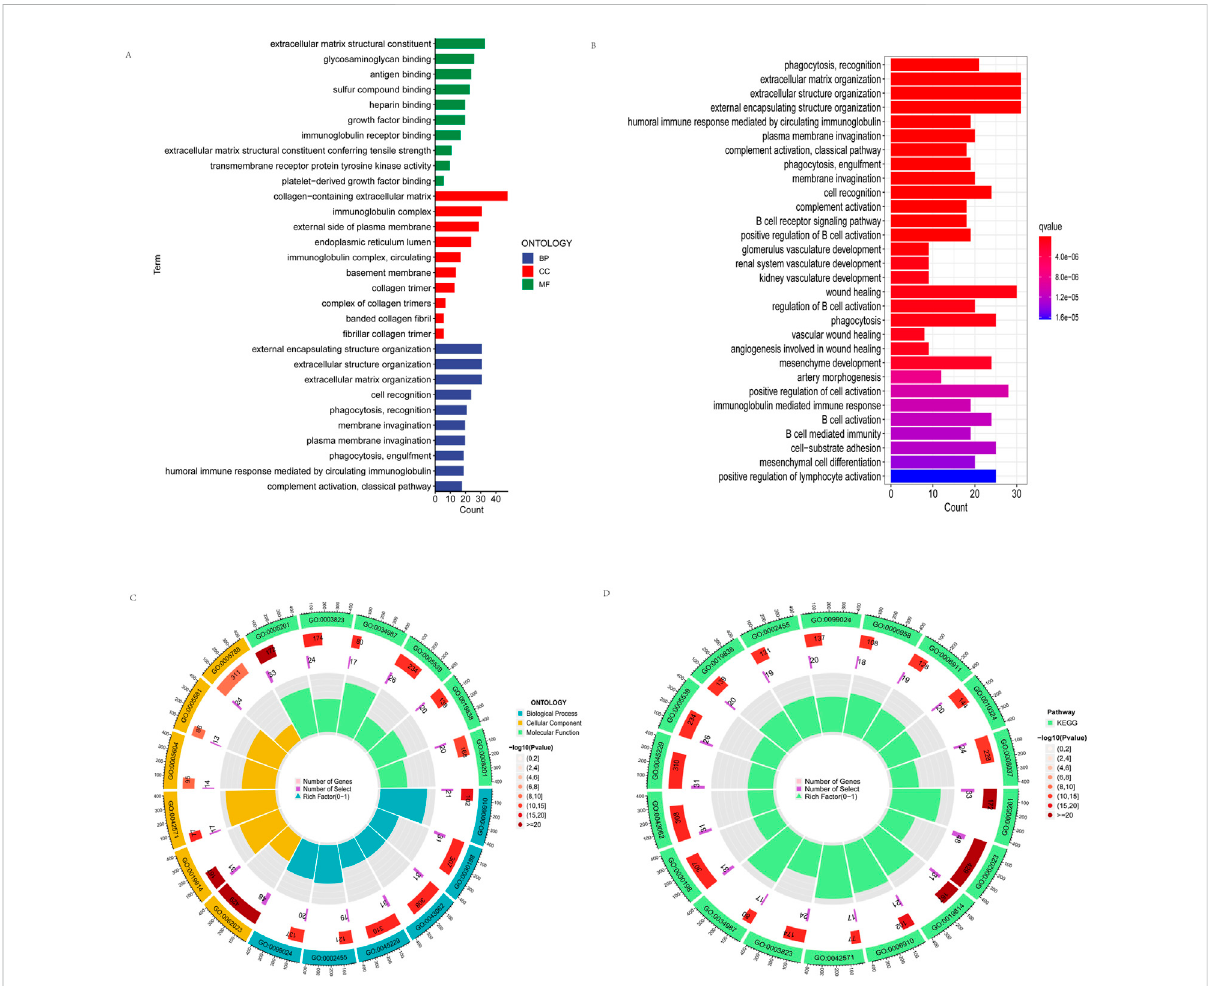
FIGURE 8 Functional enrichment analysis. (A) GO enrichment analyses of the differentially expressed genes. (B) KEGG enrichment analyses of the differentiallyexpressedgenes. (C,D)